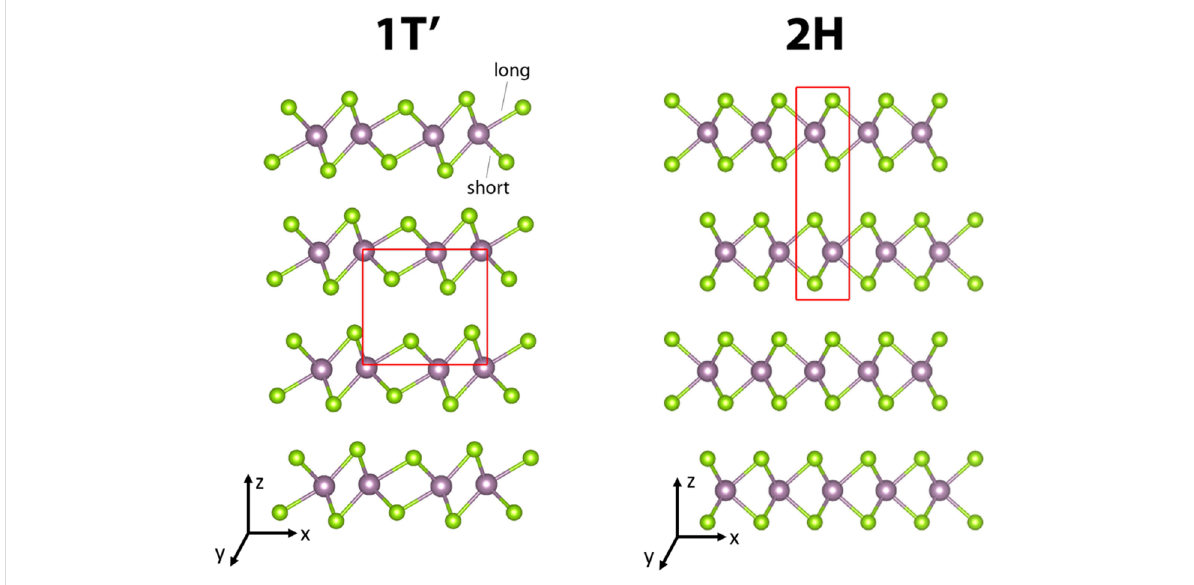
Figure 1: The illustration of atomic structures of 1T ′ and 2H TMD. Purple: Mo or W; green: S or Se. The red framework indicates the primitive cell.